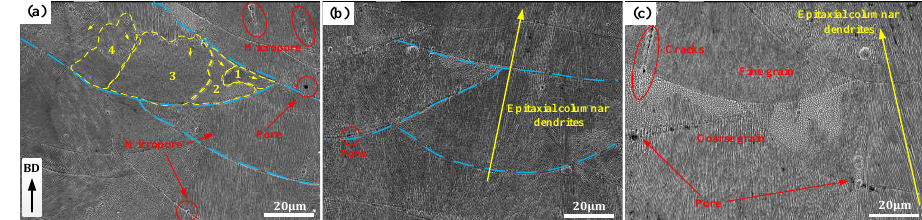
Figure 4. The microstructure morphology: ( a ) VED = 60 J·mm −3 , ( b ) VED = 96 J·mm −3 , and ( c ) VED = 119 J·mm −3 . The yellow line shows the orientation of the sub-grain and blue line shows the boundary of the melt pool.